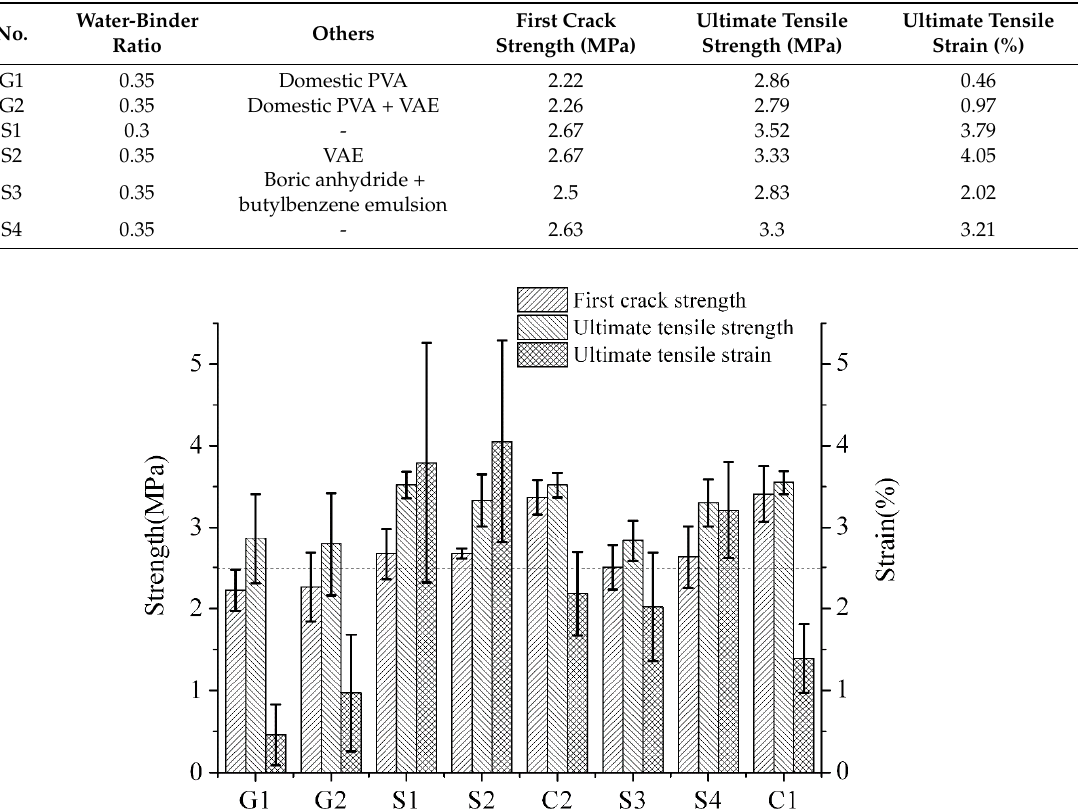
Figure 6. Tensile strength and strain of ECC.